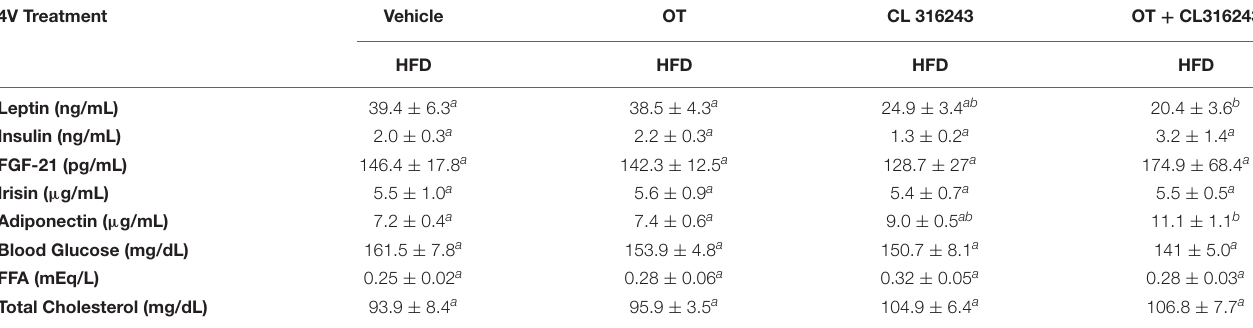
TABLE 6 | Plasma measurements following 4V infusions of OT (16 nmol/day), CL 316243 (0.5 mg/kg), or OT (16 nmol/day) + CL 316243 (0.5 mg/kg) in DIO rats. 4V